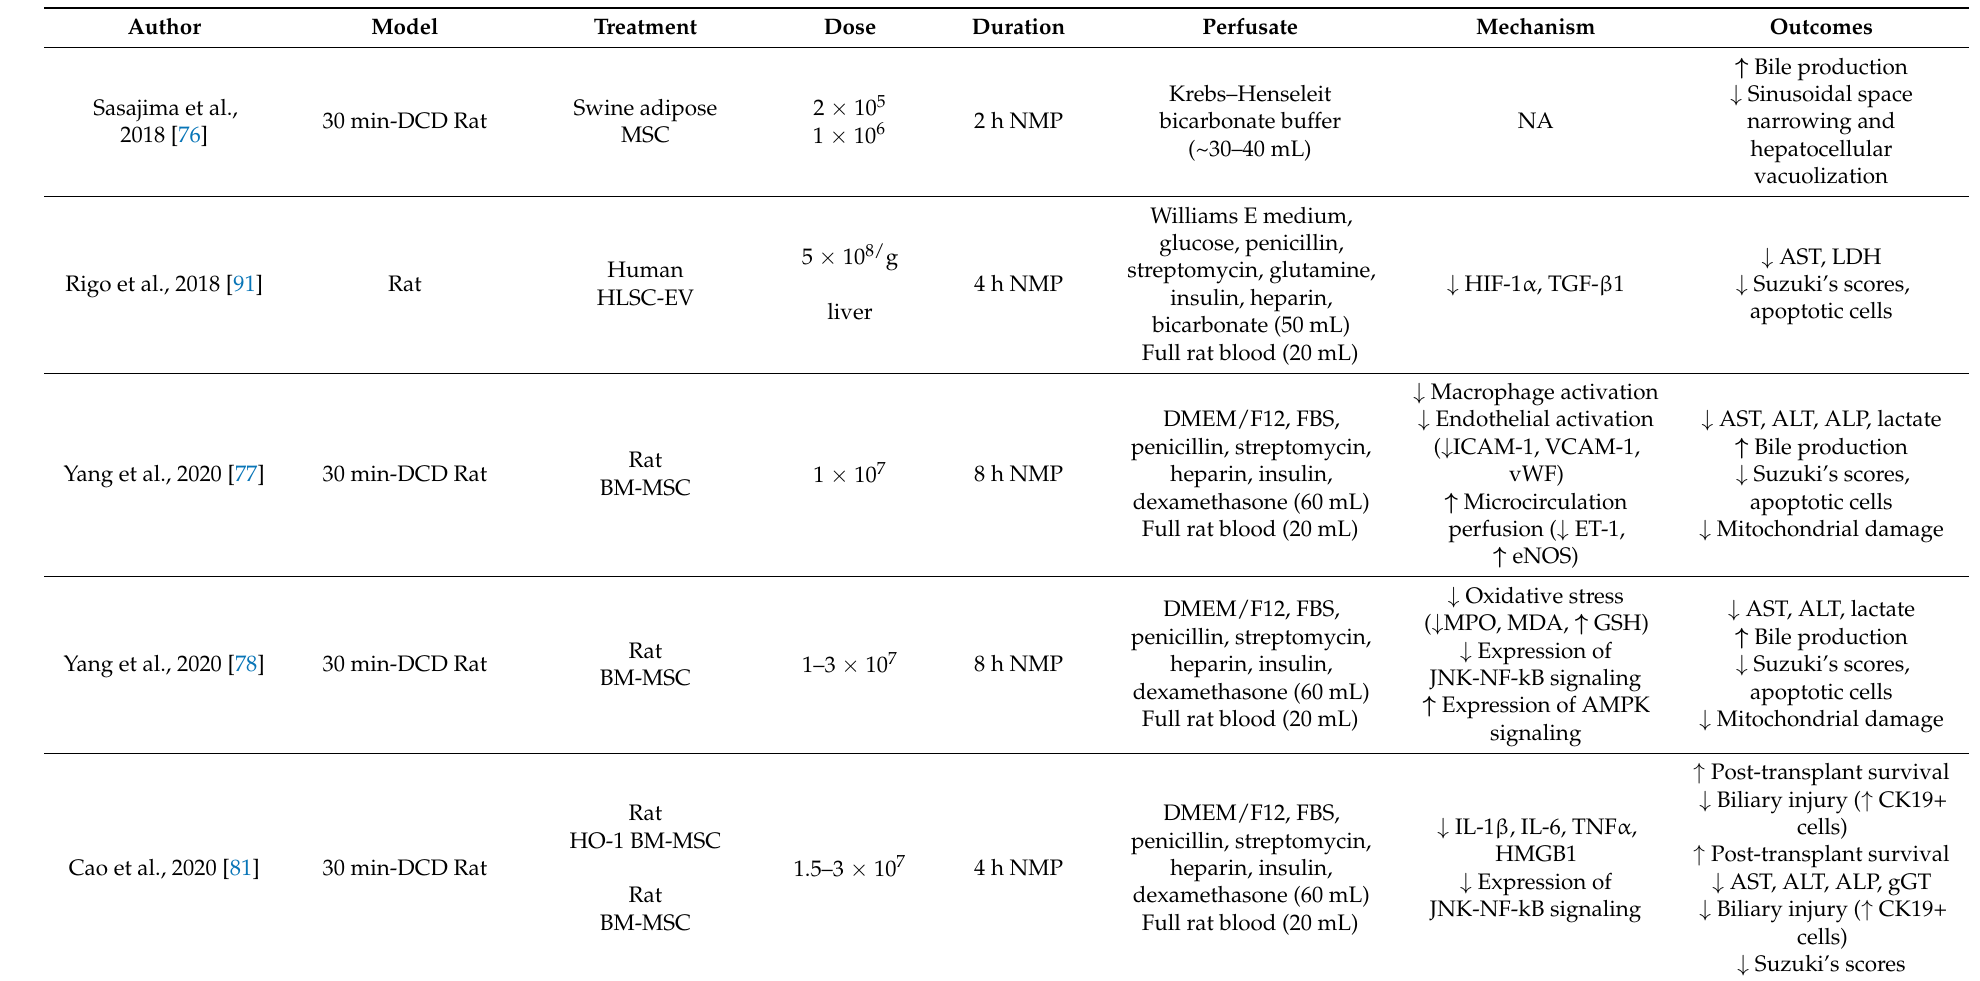
Table 3. Schematic overview of preclinical studies investigating MSC-based therapies administered during dynamic liver